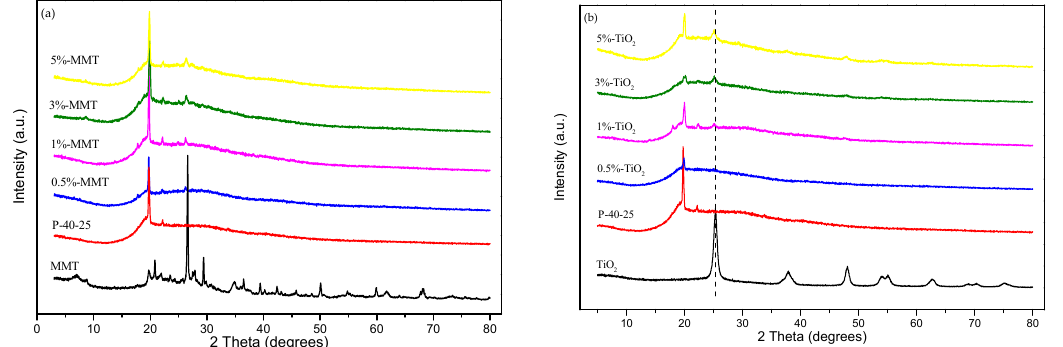
Figure 4. XRD patterns of ( a ) MMT: P‐40‐25, 0.5%‐MMT, 1%‐MMT, 3%‐MMT, and 5%‐MMT and ( b ) TiO 2 : P‐40‐25, 0.5%‐ TiO 2 , 1%‐ TiO 2 , 3%‐ TiO 2 , and 5%‐ TiO 2 . ( b ) TiO 2 : P-40-25, 0.5%- TiO 2 , 1%- TiO 2 , 3%- TiO 2 , and 5%- TiO 2